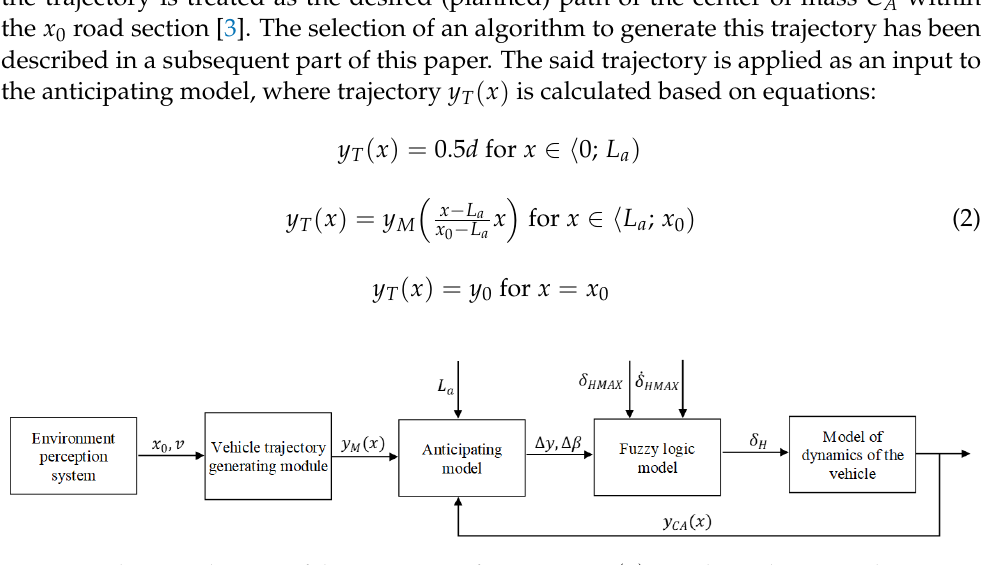
Figure 2. Structure of the control system.